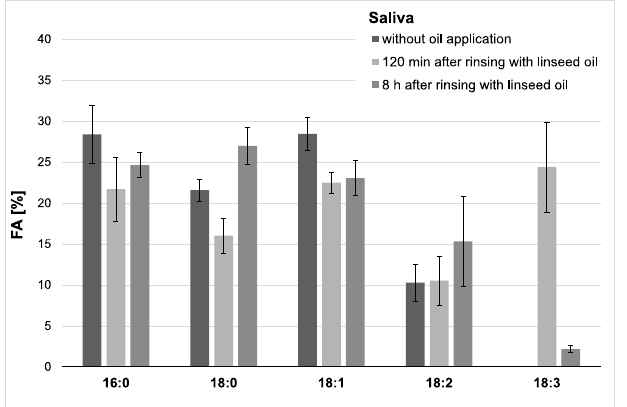
Figure 4. Percentage of the four major fatty acids and 18:3 in the saliva’s total fatty acid profile. The mean values and standard deviation are shown based on the data from five participants (n=5).